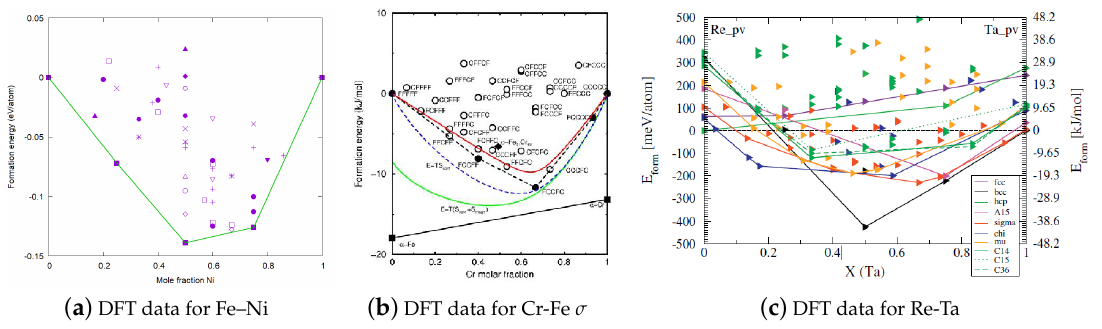
Figure 11. ( a ) The 47 DFT calculations made in Fe–Ni. ( b ) The 32 DFT calculations made for the σ phase in Cr-Fe by Korzhavyi et al. [5]. ( c ) Many DFT calculations for several phases in the Re-Ta system from Palumbo et al.